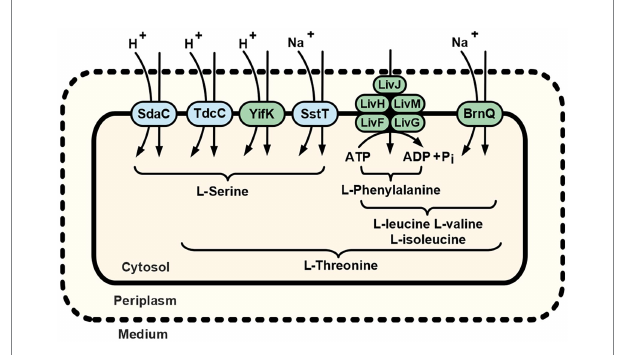
FIGURE 6 Schematic of the L-serine and L-threonine uptake routes in E. coli K-12 cells. Dotted and solid lines represent the outer and cytoplasmic membranes, respectively. Amino acid designations under braces indicate the substrate specificity of indicated transport systems. Green highlighting indicates the transport systems first discovered and reported in the present work (YifK) or characterized as carriers capable of translocating threonine (LIV-I and BrnQ). Previously known serine/threonine carriers (SdaC, TdcC, and SstT) are highlighted in blue. For more details, see the